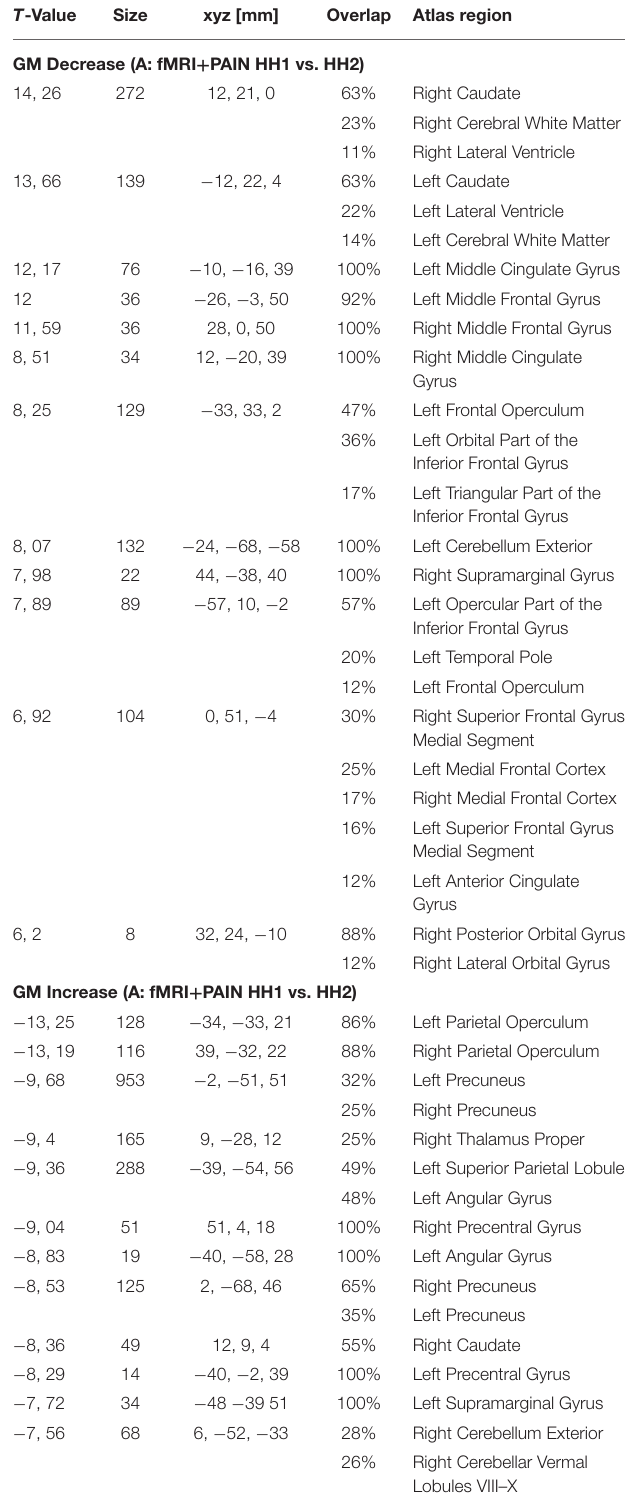
TABLE 1 | MNI-coordinates, maximum T -value, cluster size (in voxel) above threshold and anatomical site ( p < 0.05 FWE-corrected) are reported for GM changes in experiment A of the Hamburg data (fMRI +